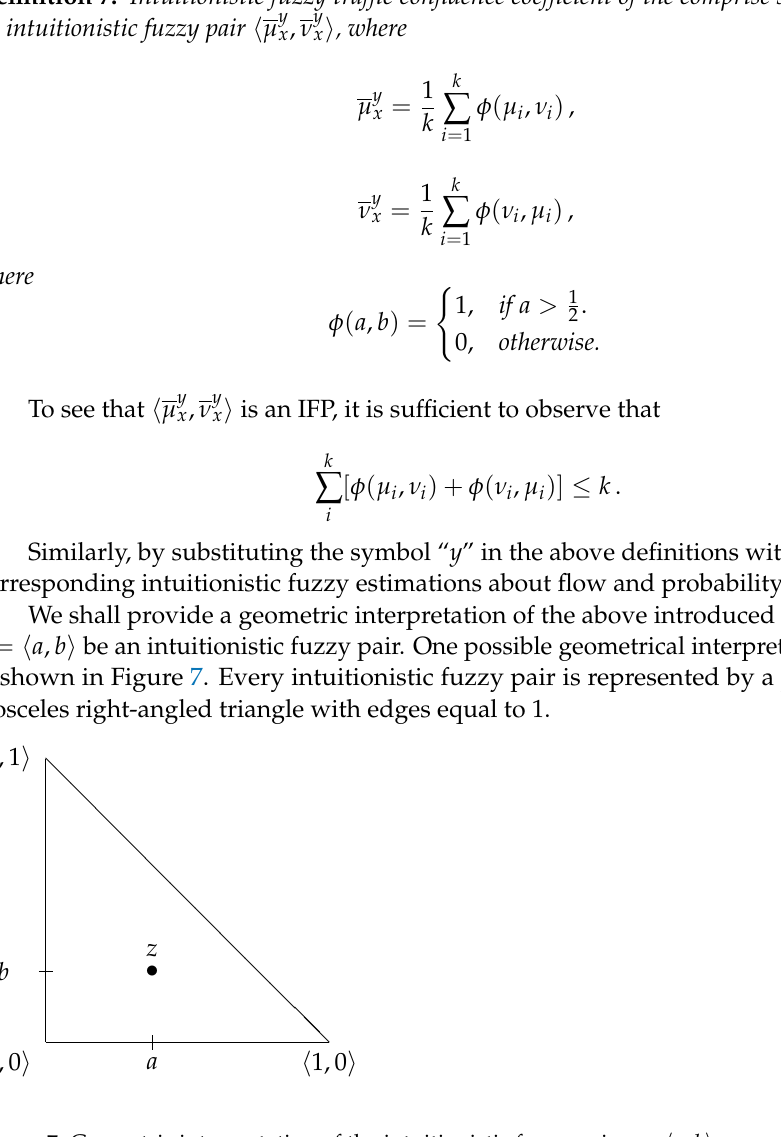
Figure 7. Geometric interpretation of the intuitionistic fuzzy pair z = (cid:104) a , b (cid:105)